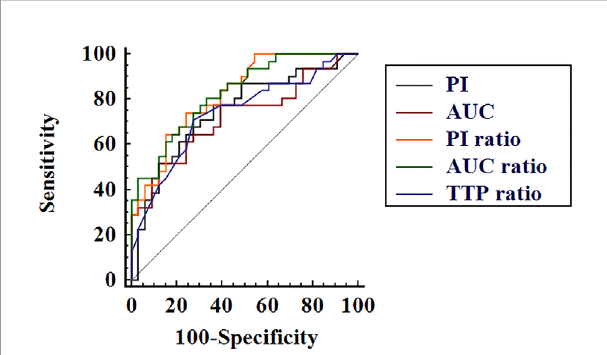
FIGURE 3 | Receiver operating characteristic curves of contrast-enhanced ultrasound quanti fi cation parameters peak intensity (PI), area under the time –